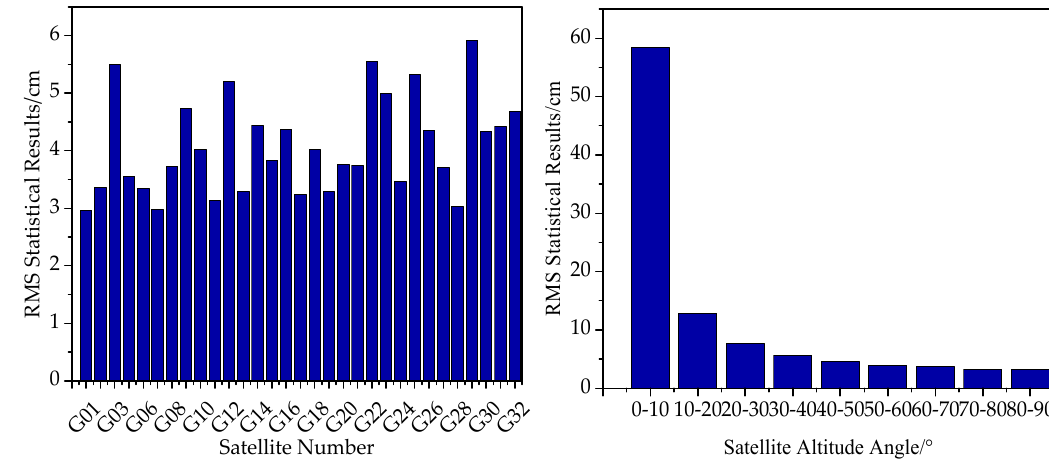
Figure 5. The root mean square (RMS) of the STD di ff erences between simulated and Global Navigation Figure. 5 The root mean square (RMS) of the STD differences between simulated and Global Satellite System (GNSS) STD with satellite and satellite elevation Navigation Satellite System (GNSS) STD with satellite and satellite elevation angle.